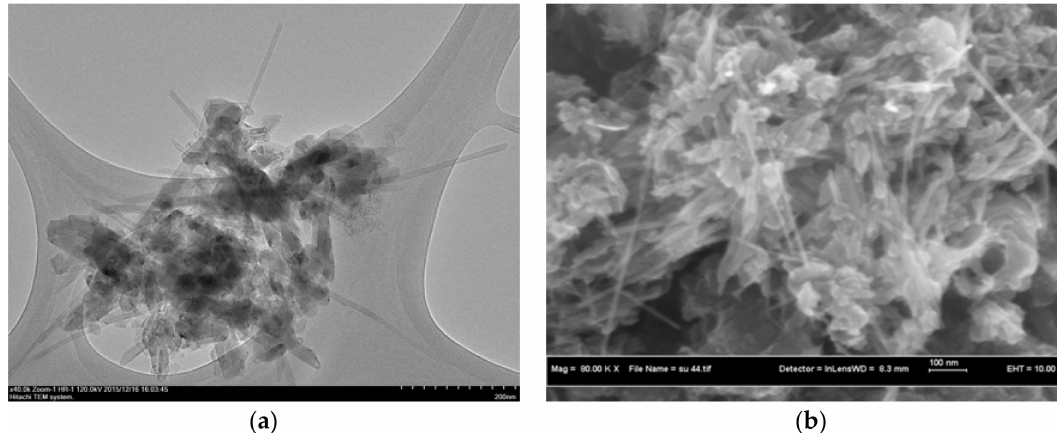
Figure 7. Formation of the MWCNT bundle as monitored in ( a ) transmission electron microscope (TEM) and ( b ) field emission scanning electron microscope (FESEM) images.